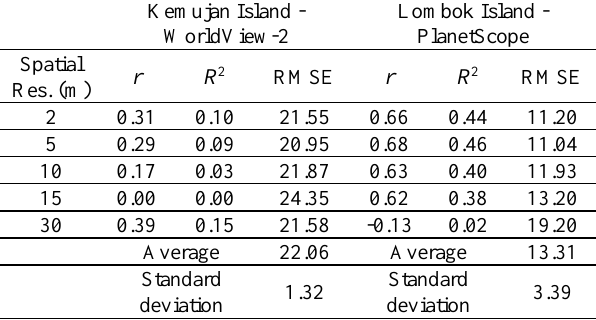
Table 1. Summary of accuracy assessment of seagrass percent cover mapping at different spatial